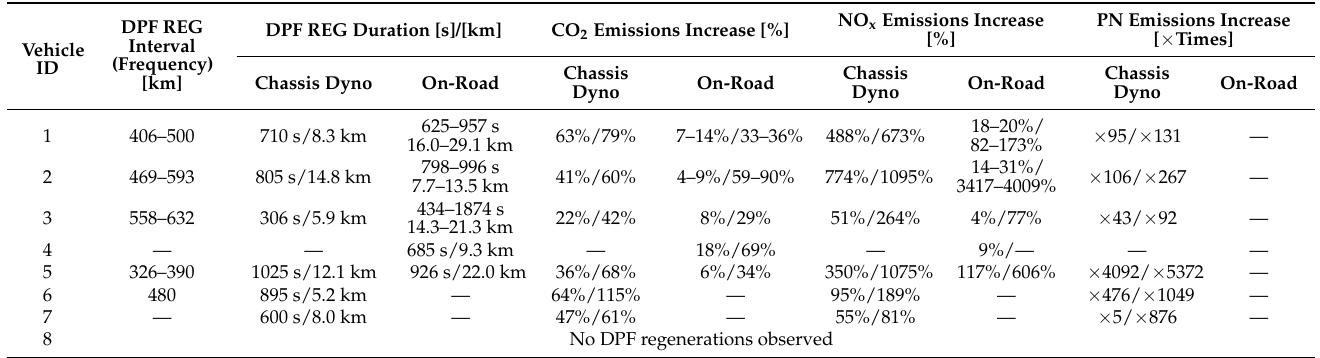
Table 3. Impact of DPF regeneration on CO 2 , NO x and PN emissions throughout the complete test/during the regeneration period only. The calculations are made by comparing the tests with and without regeneration. The distance and duration of the laboratory tests were 11–23 km or 20–30 min approximately. The distance and duration of the on-road tests were around 80–140 km and 1.5–2.5 h